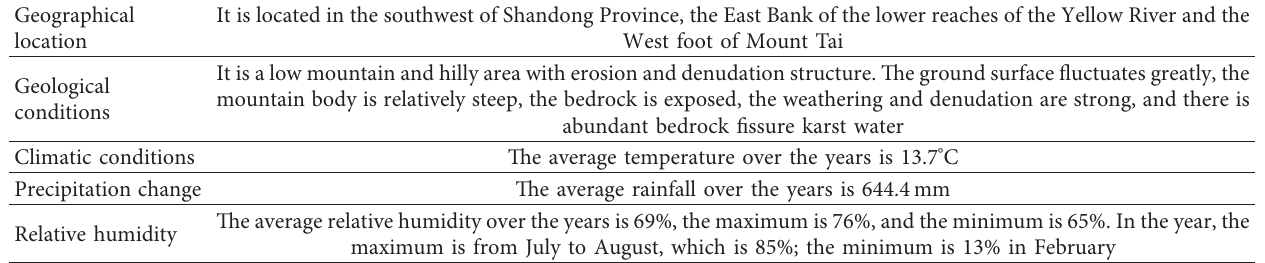
Table 1: General situation of engineering geology.